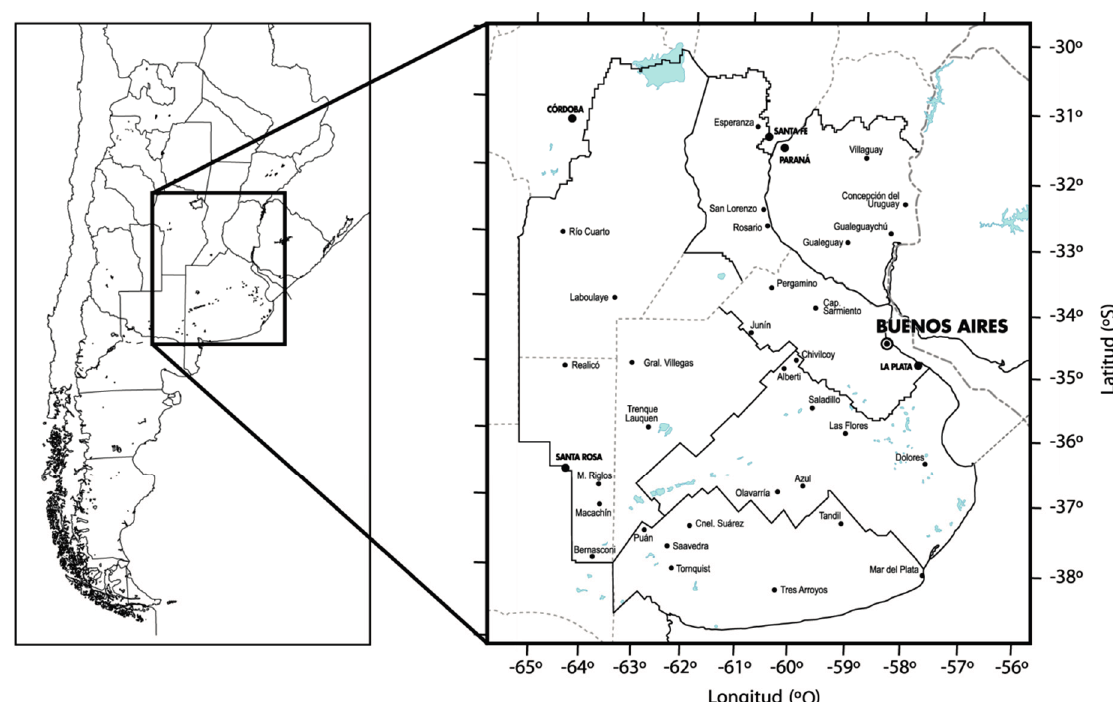
Figure 1. Location map of the Pampa Region, sub regions and